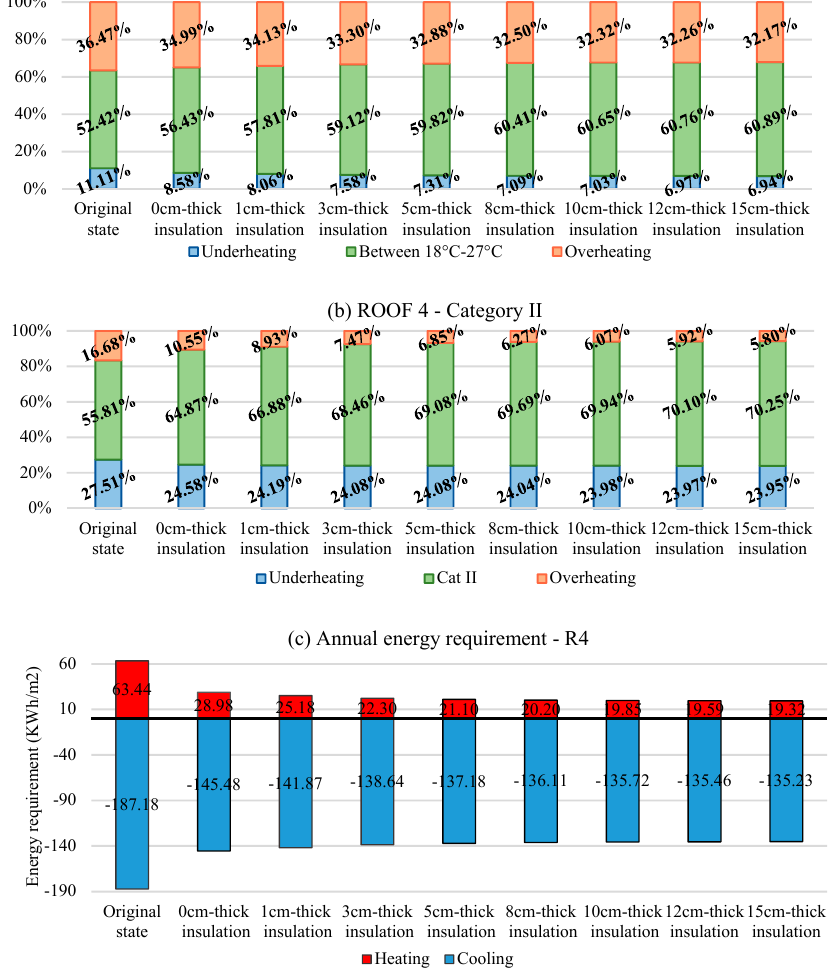
Figure 12. Comfort rates according to the static ( a ) and the adaptive ( b ) approach and annual energy requirement ( c ) for the roof R4 according to different insulation thicknesses.